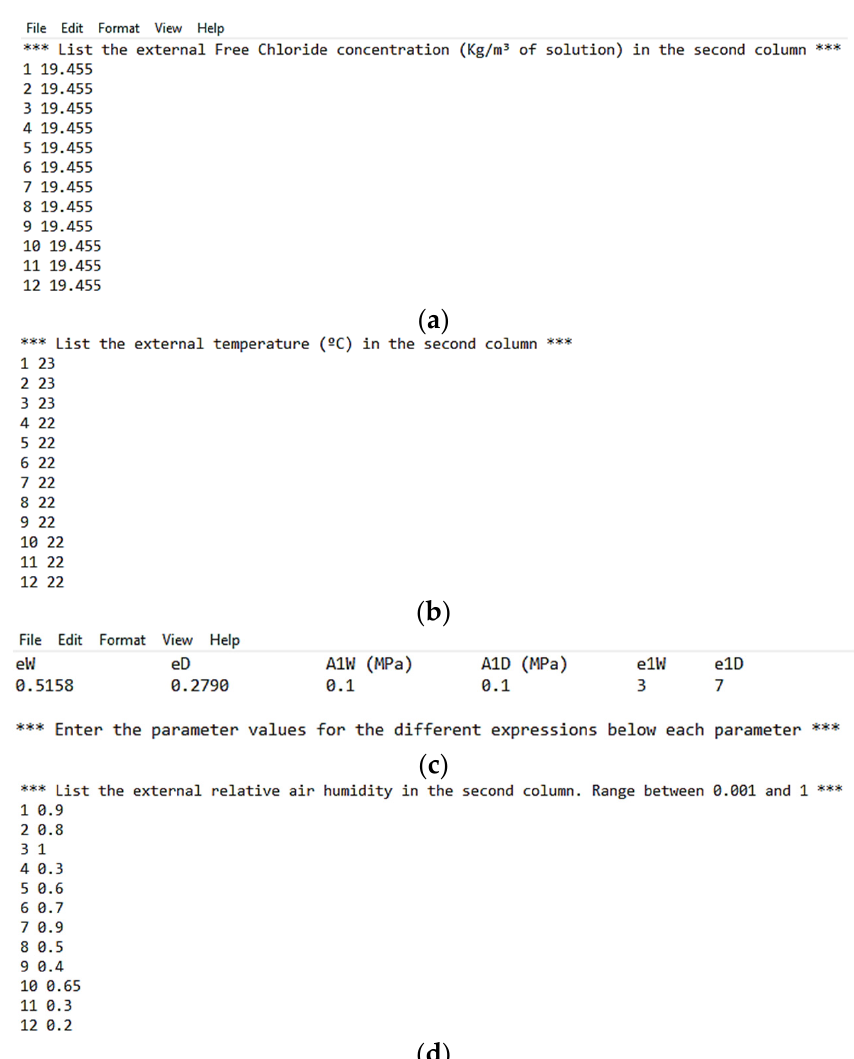
Figure 10. Window for introducing: ( a ) the list of free chloride concentrations at the boundary, ( b ) the list of temperature at the boundary, ( c ) the parameters related to capillary pressure and diffusion coefficient, ( d ) the relative humidity table.